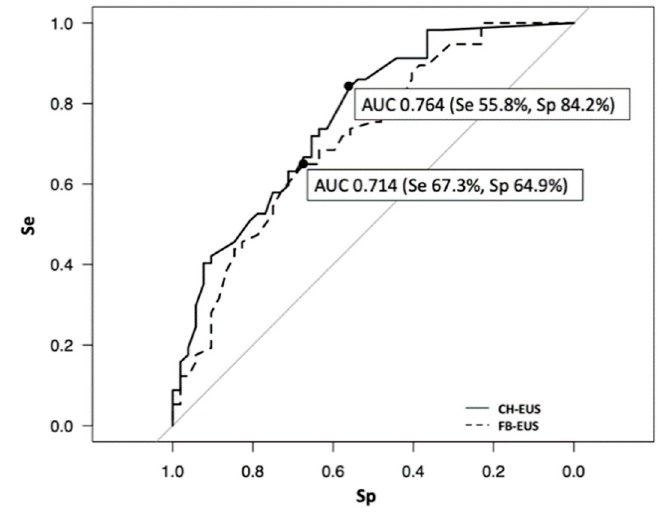
Figure 7. Comparison of the ROC curves of nodule height evaluated using CH-EUS and FB-EUS. The highest diagnostic value of the evaluation of the nodule height using CH-EUS was calculated as 5 mm with an AUC of 0.764 (Se 55.8%, Sp 84.2%) using the ROC curve analysis. The highest diagnostic value of the evaluation of the nodule height using FB-EUS was calculated as 8 mm with an AUC of 0.714 (Se 67.3%, Sp 64.9%) using the ROC curve analysis. CH-EUS, contrast-enhanced harmonic endoscopic ultrasound; FB-EUS, fundamental B-mode endoscopic ultrasound; ROC, receiver-operating characteristic; AUC, area under the curve.